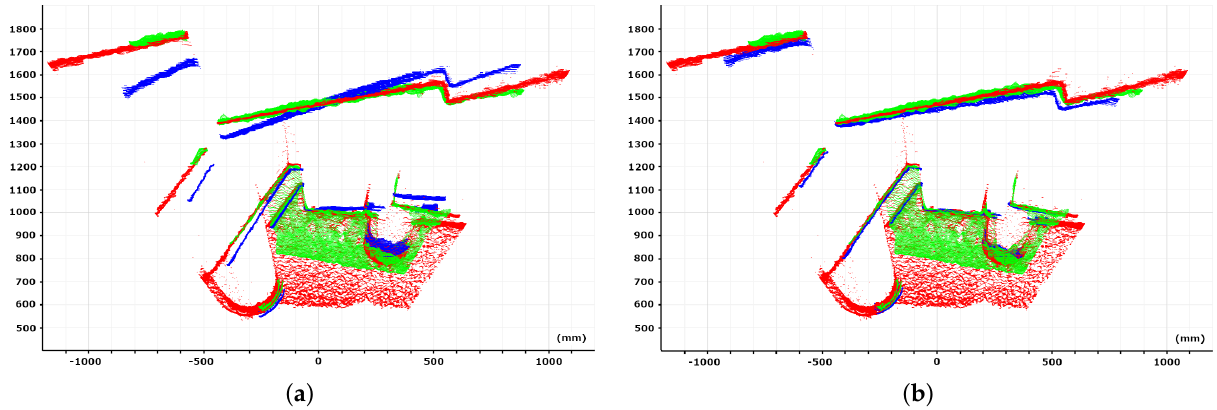
Figure 11. Blue, green and red colors correspond to the 3D world points acquired with the Orbbec Astra, the Intel D415, and the Intel L515 when ( a ) no correction and ( b ) correction is applied to the Orbbec Astra